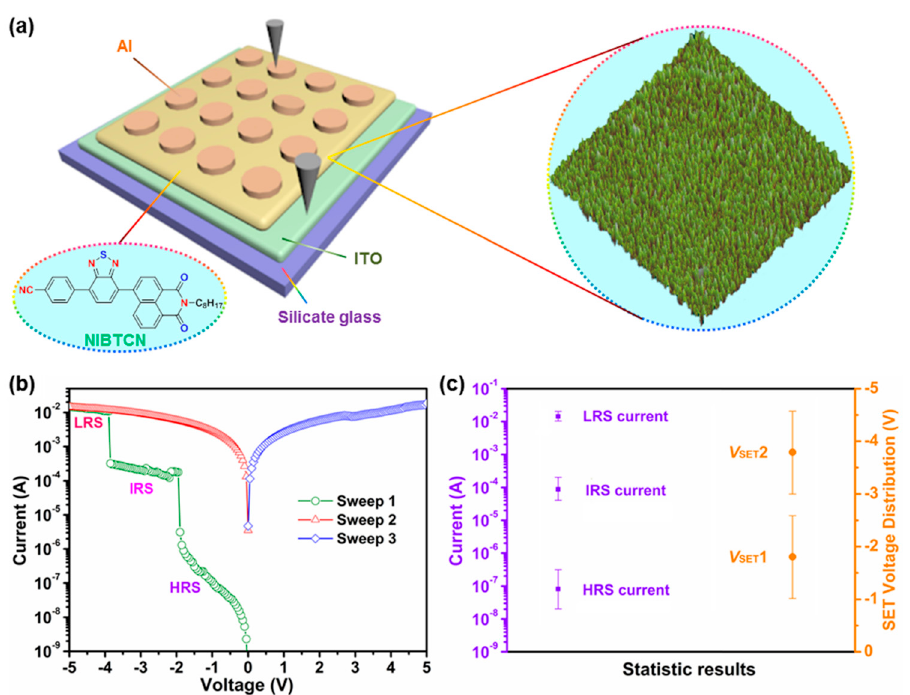
Figure 3. ( a ) The schematic illustration of the metal-insulator-metal (MIM) type NIBTCN-based device, including silicate glass substrate, ITO, NIBTCN layer, and top Al electrode. ( b ) I–V characteristics of NIBTCN-based device. ( c ) The statistical data for the three current states (high-resistance state (HRS), intermediate-resistance state (IRS), low-resistance state (LRS)) and two threshold voltages ( V SET 1 and V SET 2) of NIBTCN-based device depicted by error bars.